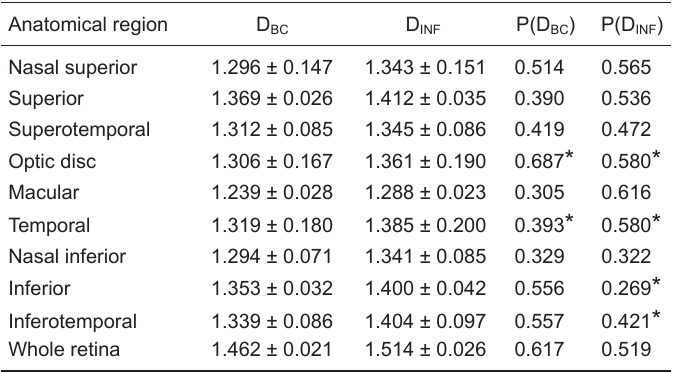
Table 2. Box-counting (D BC ) and information (D INF ) methods for determin- ing the fractal dimension of each anatomical retinal region and of the whole retina of 5 patients with non-proliferative diabetic retinopathy